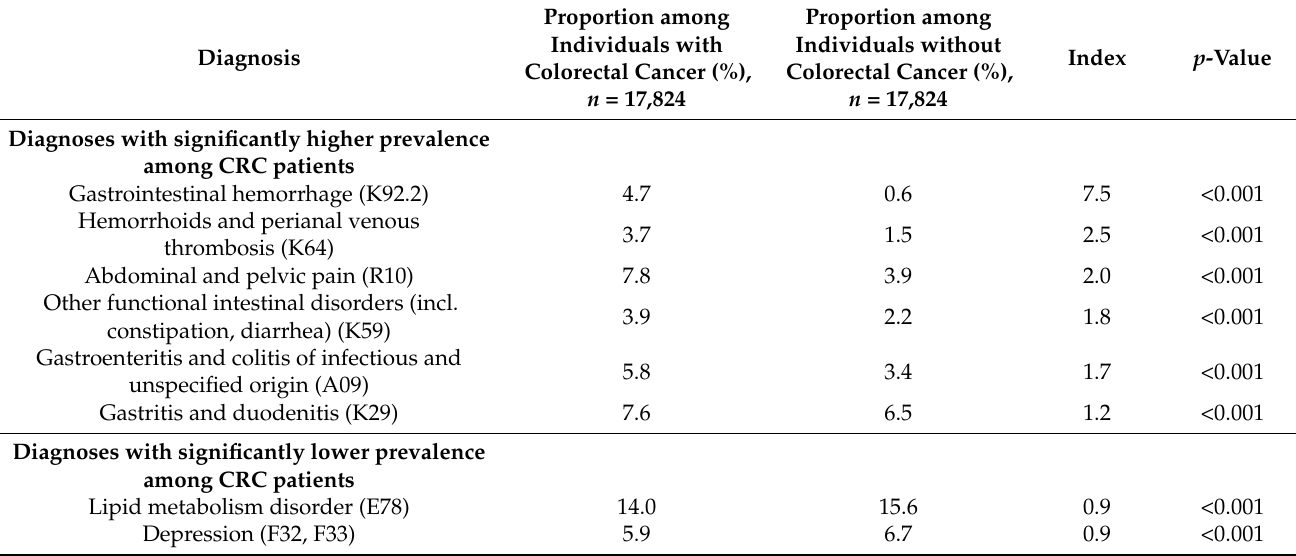
Table 2. Prevalence of different co-diagnoses documented within 12 months before the diagnosis of colorectal